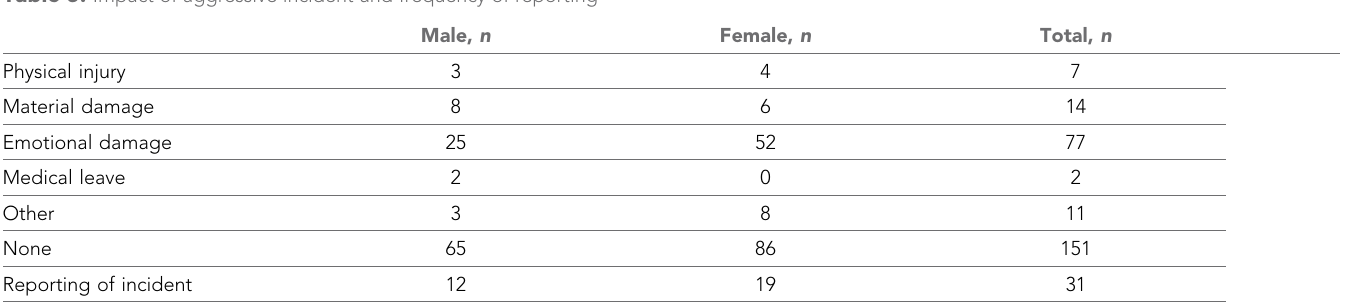
Table 5. Impact of aggressive incident and frequency of